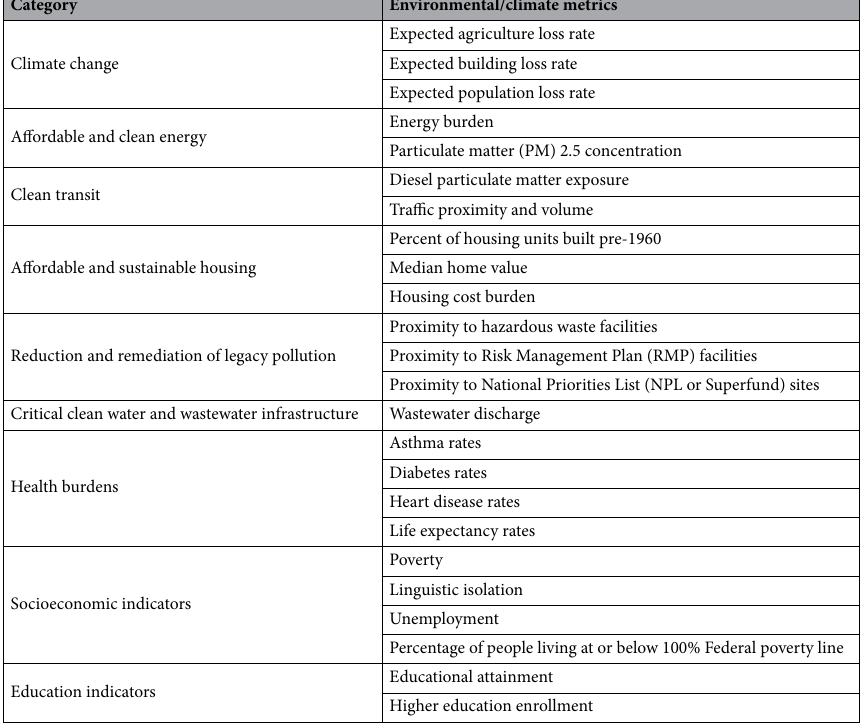
Table 2. Climate and economic justice screening tool metrics. Source: White House Council on Environmental Quality 60